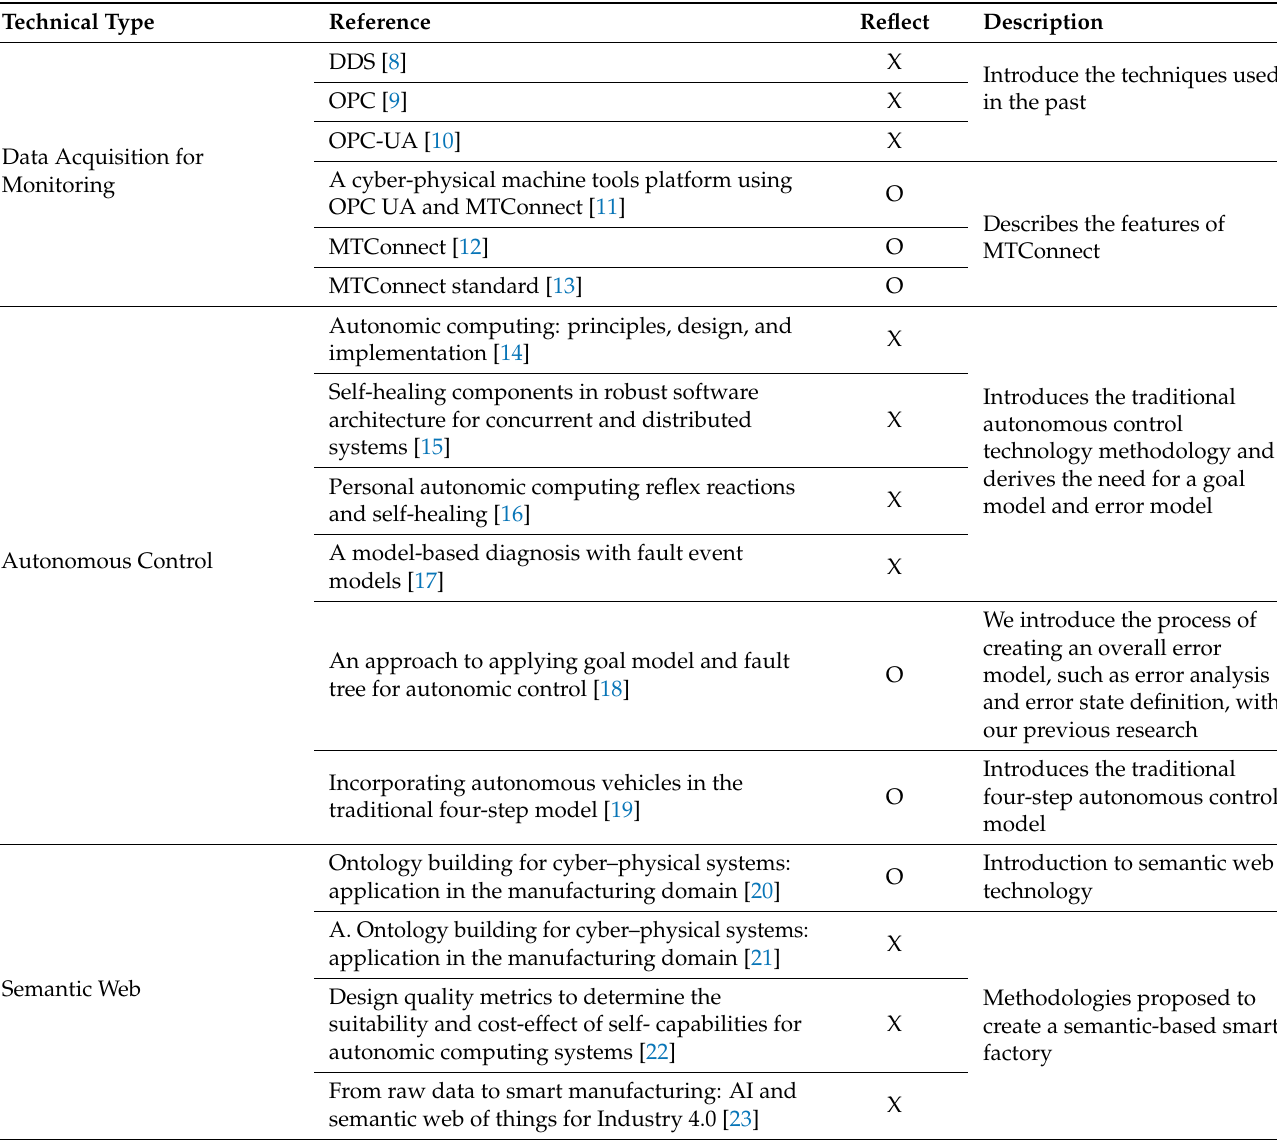
Figure 9. SPARQL sample. Table 6. Reference